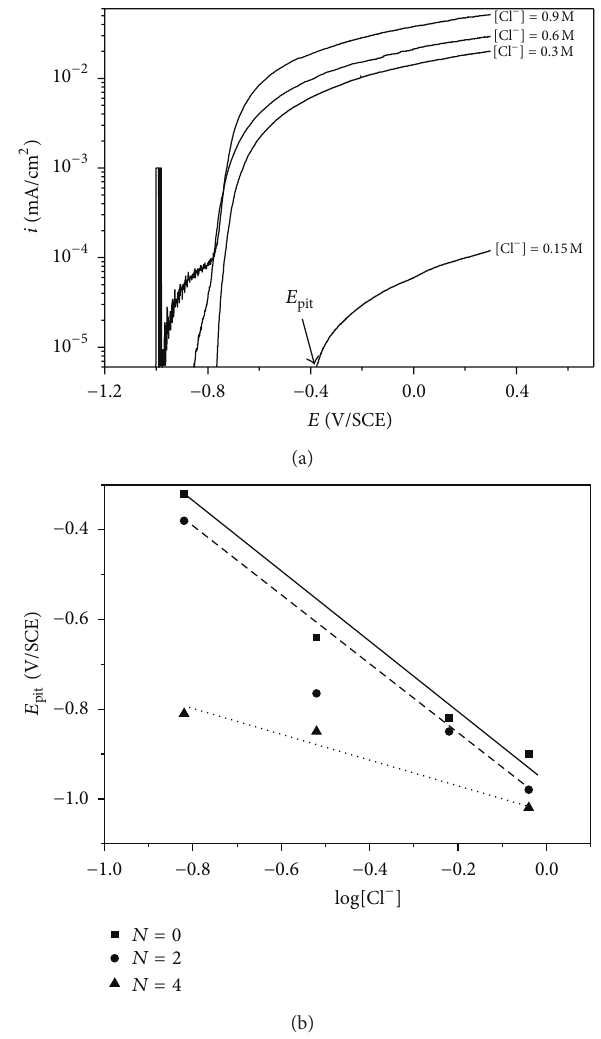
Figure 8: Polarization curves of the ECAP’ed sample ( 𝑁 = 2 ) in different NaCl concentrations at pH = 6.4, 25 ∘ C, scan rate of as a function log[Cl − ] for the 10mV ⋅ s −1 (a), and evolution of 𝐸 pit nonpressed ( 𝑁 = 0 ) and ECAP’ed samples ( 𝑁 = 2 and 4)